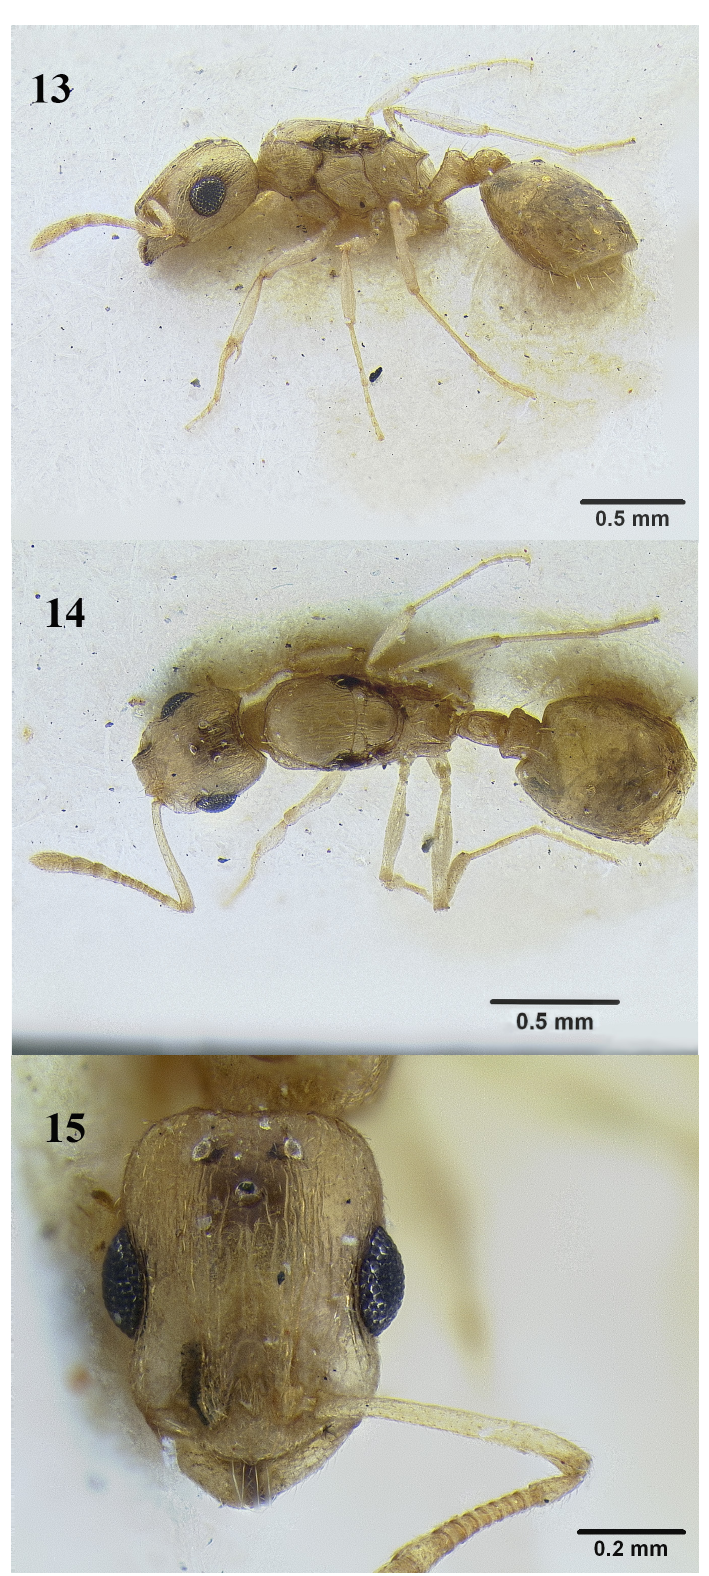
Figs 13–15 . Temnothorax megalops (Hamann & Klemm, 1967), queen (CASENT0712600). 13 . Body in profile. 14 . Body in dorsal view. 15 . Head in frontal